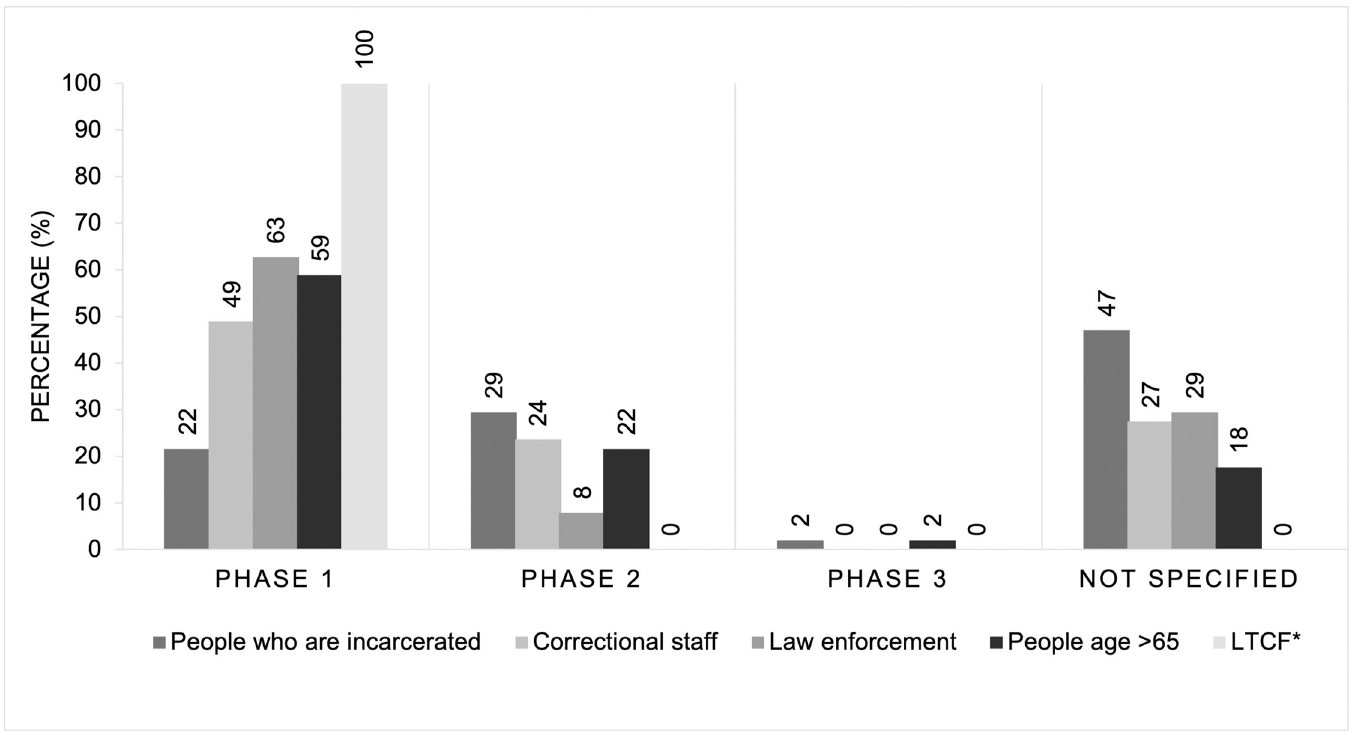
Fig 1. Percent of incarcerated people, carceral staff, law enforcement, people > 65 years, and long term care facility residents by prioritized phase in state COVID- 19 plans as of December 31, 2020. � LTCF: Long Term Care Facility.